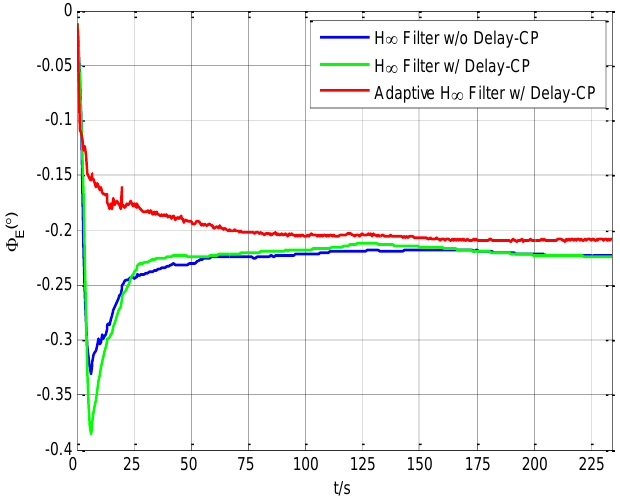
Figure 10. The estimation curves of east misalignment angle.